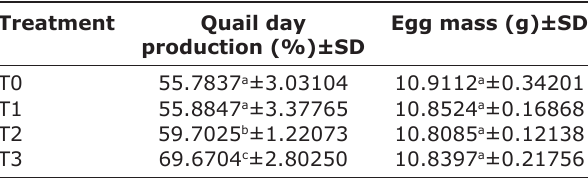
Table-3: Quail day production and egg mass of quail in 4 weeks of